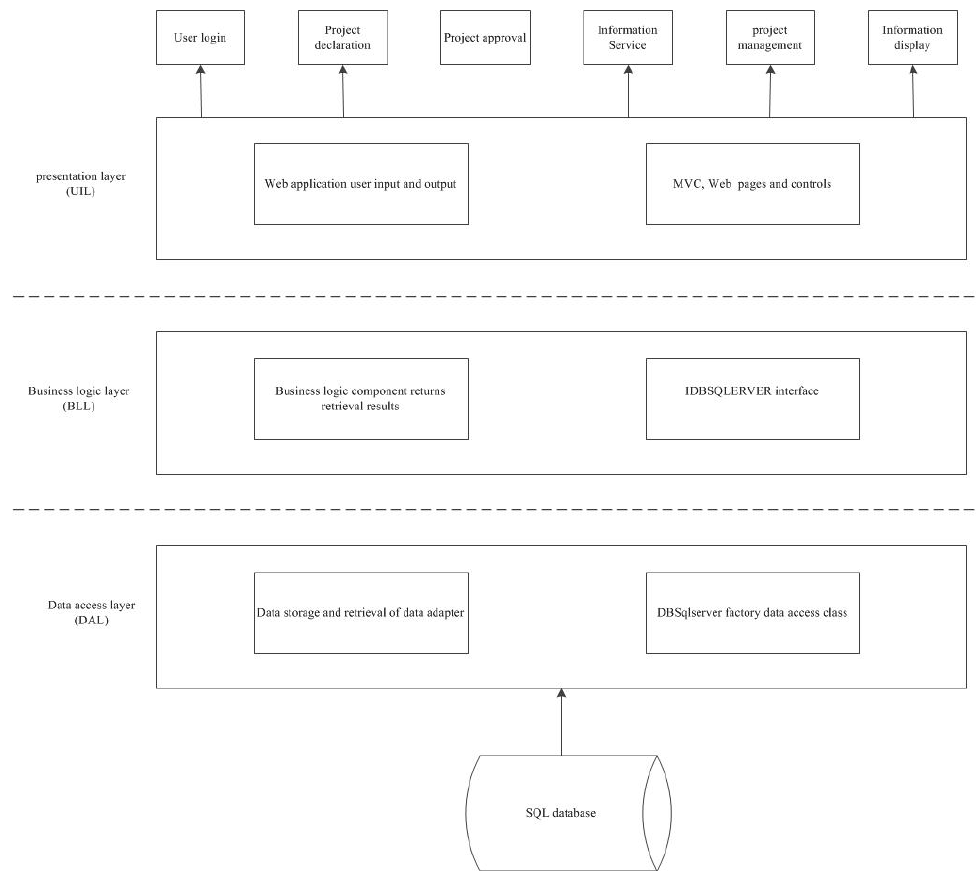
Fig. 1. System logic architecture.